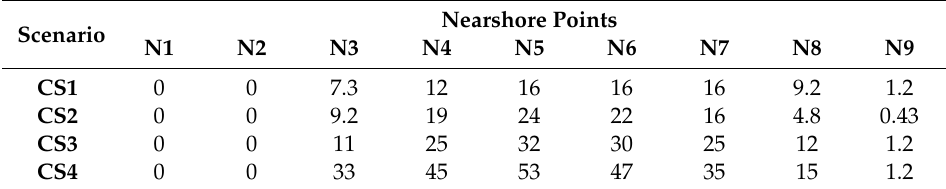
Figure 8. Influence of the generic marine farm taking into account an energetic winter event (case winter A as defined in Table 2). The results correspond to: ( a – e ) spatial variations of the wave conditions considering various scenarios. The Hs variation along the reference lines L3–L6 is also represented. The arrows field in the plot represent the wave direction. Table 5. Hs variation (%) corresponding to the N-points, considering an energetic winter event (winter A). The results were compared with the no farm